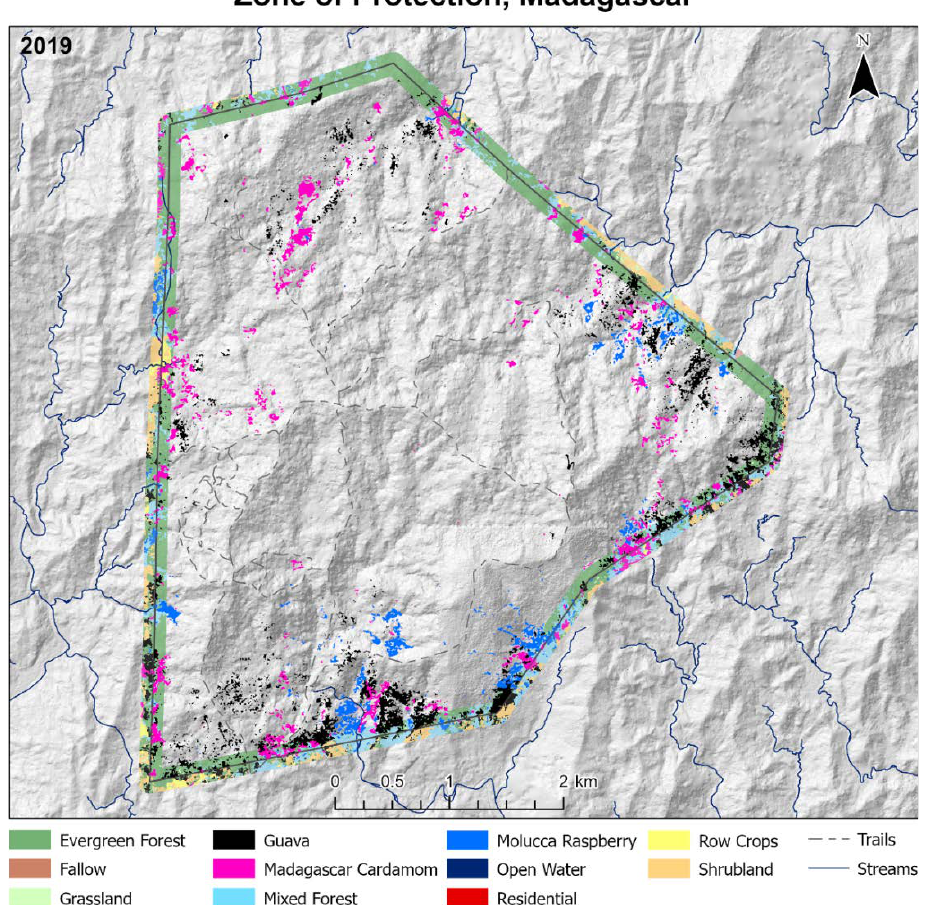
Figure 15. Invasive plant species within the BNR and the land cover types seen 100 m within the BNR boundary (gray line) and within the ZOP (100 m extending from the BNR boundary). Forest covers are observed along with a few scattered agricultural fields within the 200 m wide region on two sides of the boundary. Note that wider streams represented by the Open Water class are located further south of this map extent, which is not visible here. The Open Water and Streams classes should be treated as the same class.